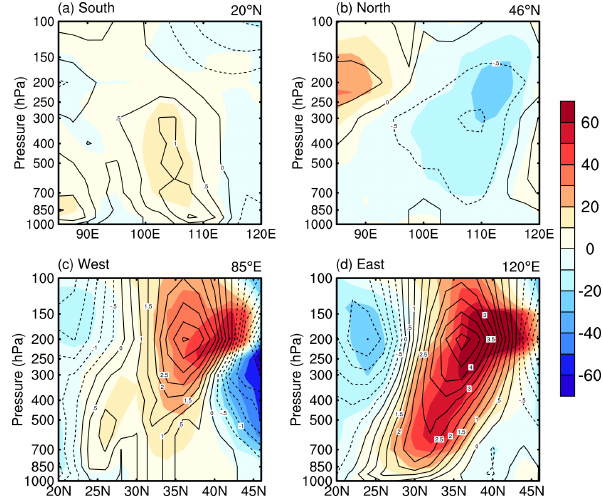
Figure 6. The composite differences in horizontal O 3 fluxes (shades, kgs − 1 ) and winds (contours, ms − 1 ) at the (a) south, (b) north, (c) west, and (d) east boundaries of the selected box (85– 120 ◦ E, 20–46 ◦ N, from the surface to 250hPa) between the five weakest and strongest EASM years (weakest–strongest). Fluxes and winds that are eastward or northward are positive, and those that are westward and southward are negative. Mass fluxes are from simu- lation O 3 _TOT. Longitudinal and meridional winds are from the GEOS-4 assimilated meteorological